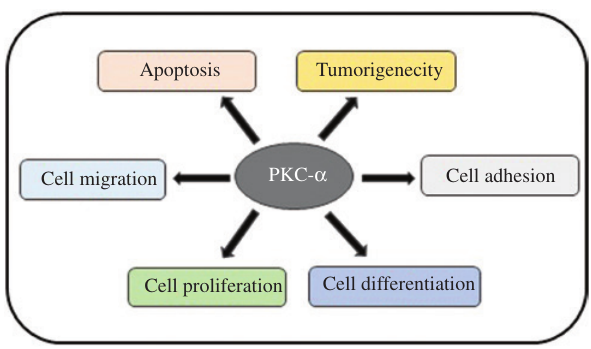
Figure 3: After activation by various stimuli, PKC- α is implicated in various cellular